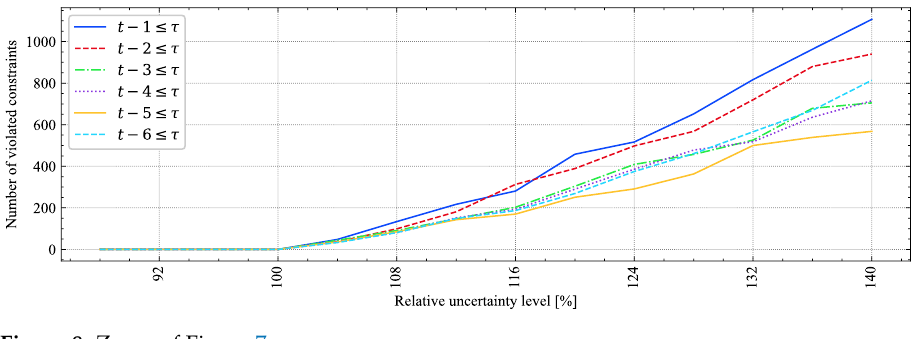
Figure 8. Zoom of Figure